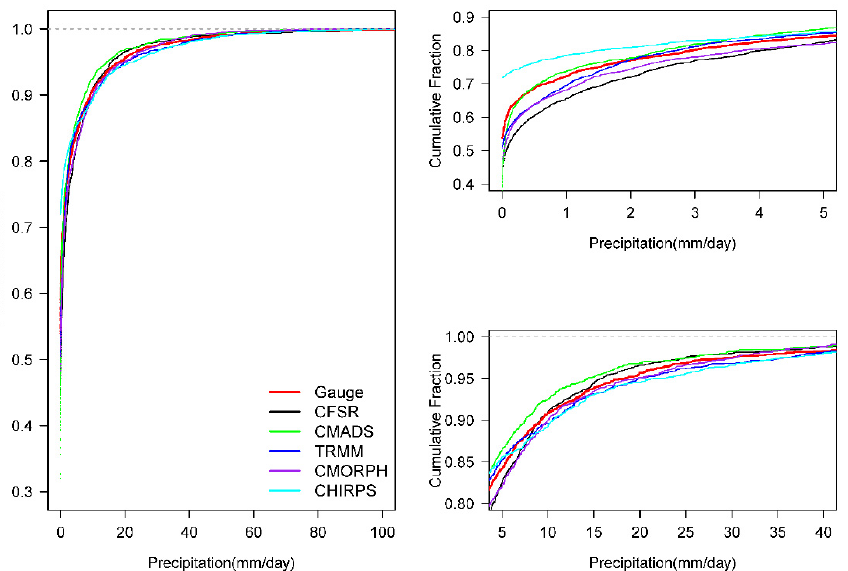
Figure 3. The cumulative fraction of daily precipitation from six datasets (Gauge, CFSR, CMADS, TRMM, CMORPH, and CHIRPS) at the watershed scale during 2009–2014. The left subfigure shows the cumulative fraction for daily precipitation ranging from 0 to 100 mm/day; in order to show more details, the two subfigures in the right show the cumulative fraction for daily precipitation ranging from 0 to 5 mm/day and 5 to 40 mm/day, respectively.